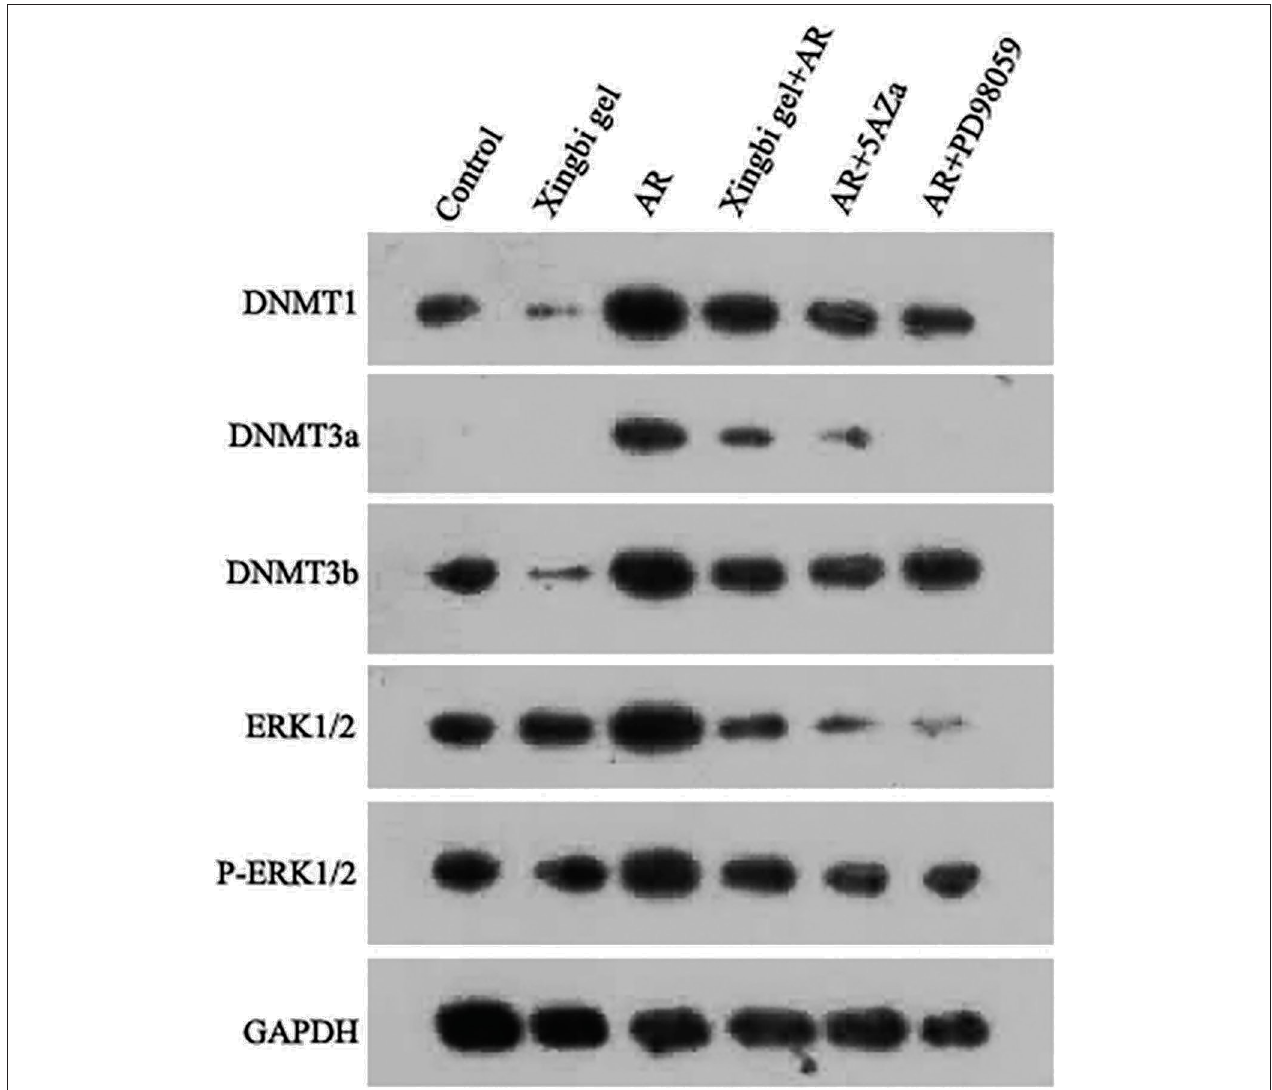
FIGURE 3 | Expression differences of DNMT1, DNMT3a, DNMT3b, ERK1/2 and P-ERK1/2 in AR